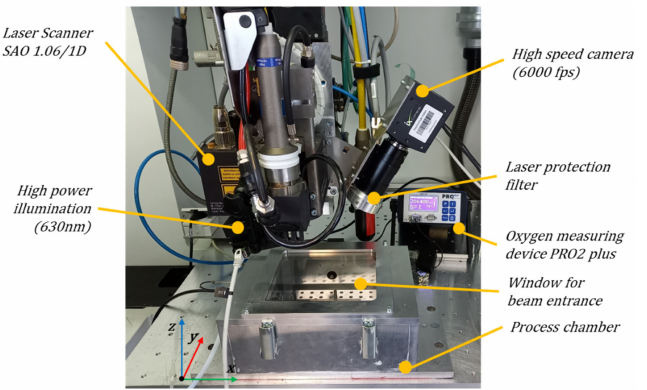
Figure 2. Experimental setup at the TRUMPF Laser Cell TLC 40 with a SAO 1.06/1D scanner optics, process chamber, oxygen measurement device PRO2 plus and high-speed camera I-Speed 221 with illumination (630